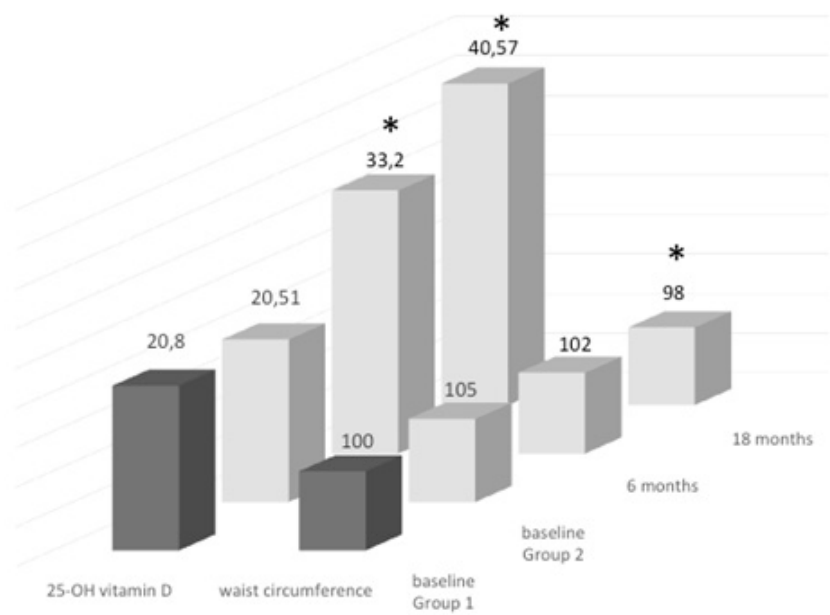
Figure 4. Serum 25(OH) D levels and waist circumference measurements at baseline in both groups of treatment, and variations along the 18-month study follow-up; * p < 0.05. Bone density did not change at the end of the study.